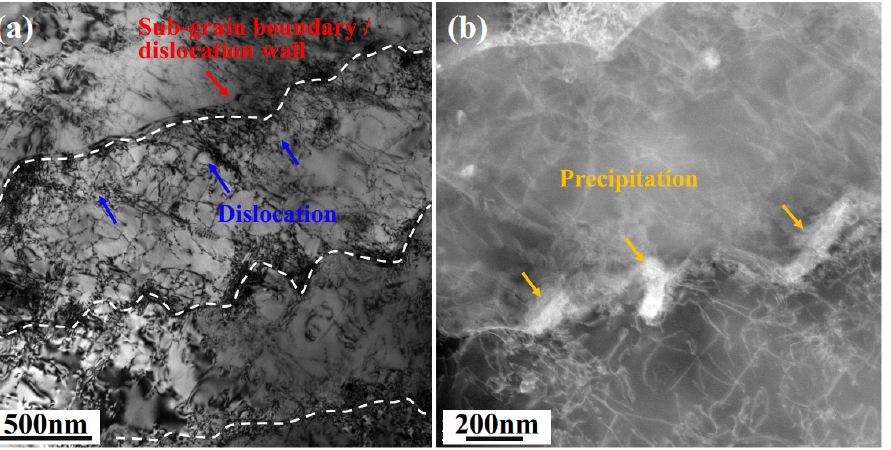
Figure 6. ( a ) TEM images containing grain boundaries and dislocations. ( b ) Dark-field image of the corresponding zone.